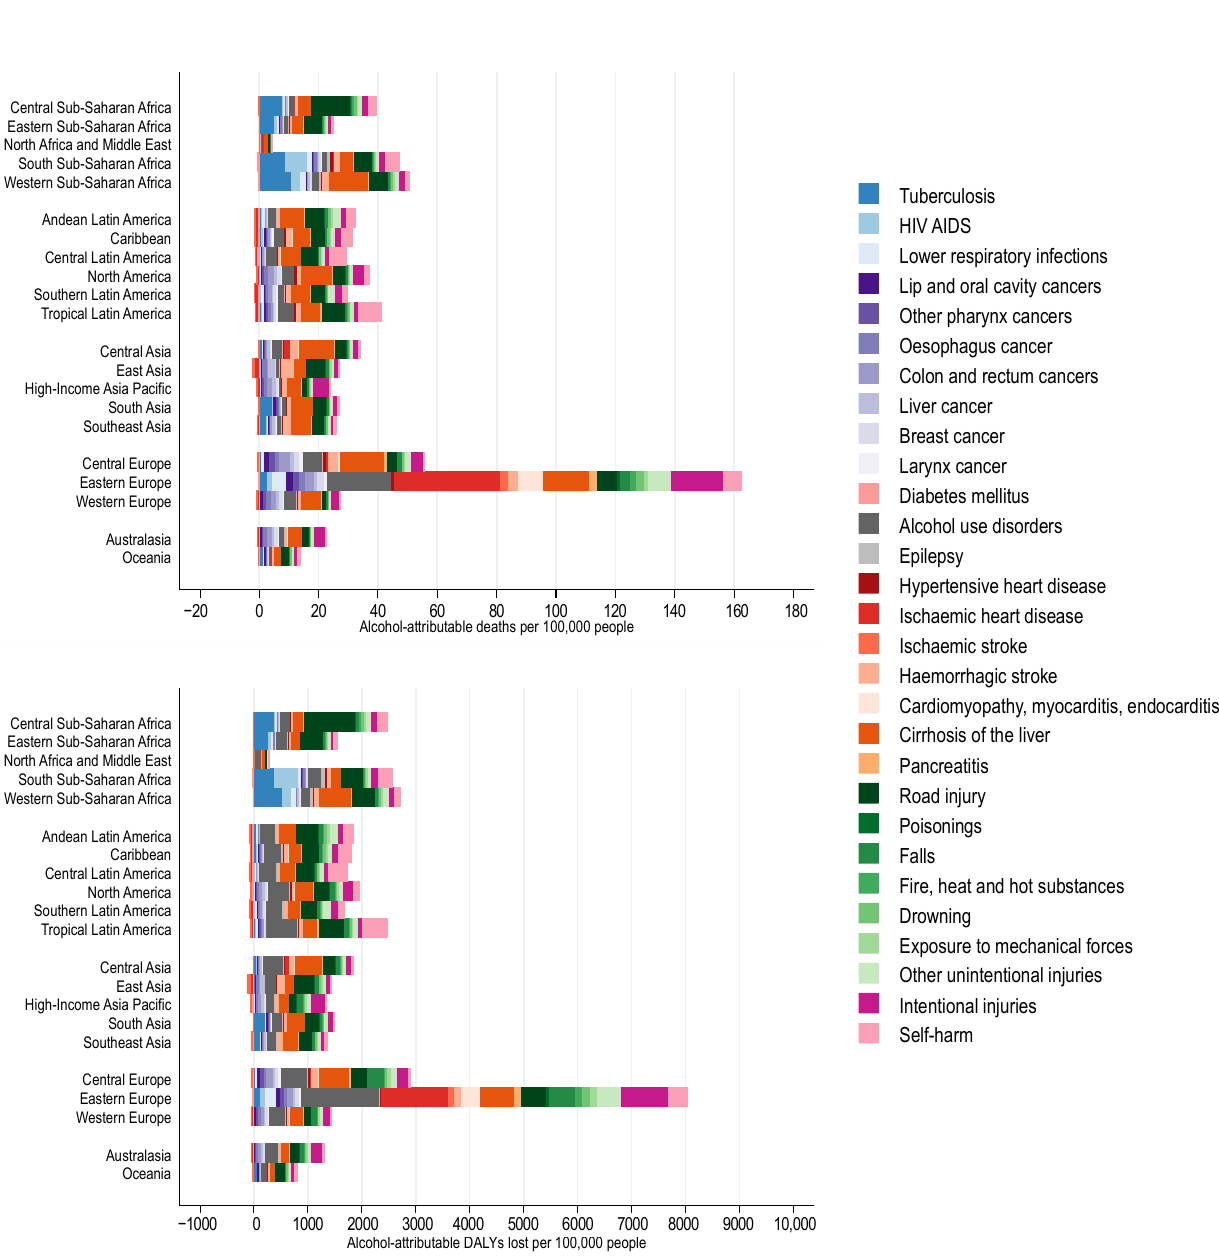
Figure 3. Alcohol-attributable deaths and disability adjusted life years (DALYs) lost among people 0 to 70 years of age by global burden of disease region.